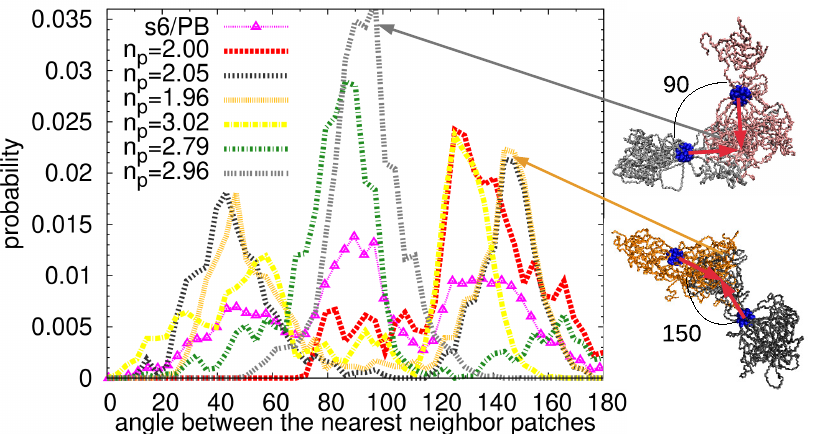
Figure 9. The probability distribution function of the intermolecular angles between the nearest neighbor patches for s6/PB system (magenta symbols). The distribution functions of the individual stars in the s6/PB system are plotted with lines, and the average number of patches per star corre- sponding to each star can be found in the legend. Characteristic snapshots of mutual configurations of two stars with angles between the patches of 90 and 150 degrees are shown on the